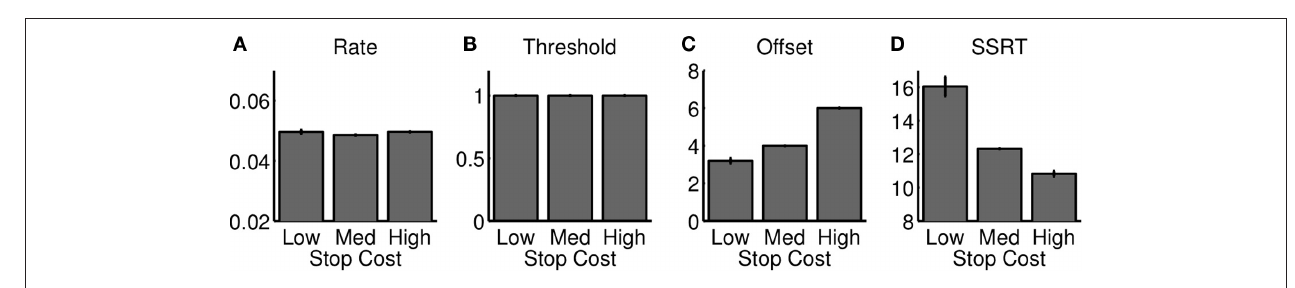
Figure 7 | race model approximation to optimal decision-making as stop error penalty is varied. The figure shows the best race parameters, implemented as a diffusion model shown in Figure 2 , that approximate the behavior of the optimal model, as the cost of stop errors is changed. The temporal offset to